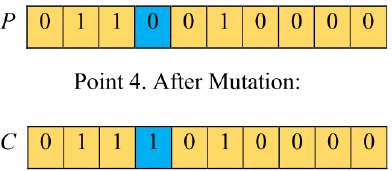
Figure 5. Example of the ineffective bit flip